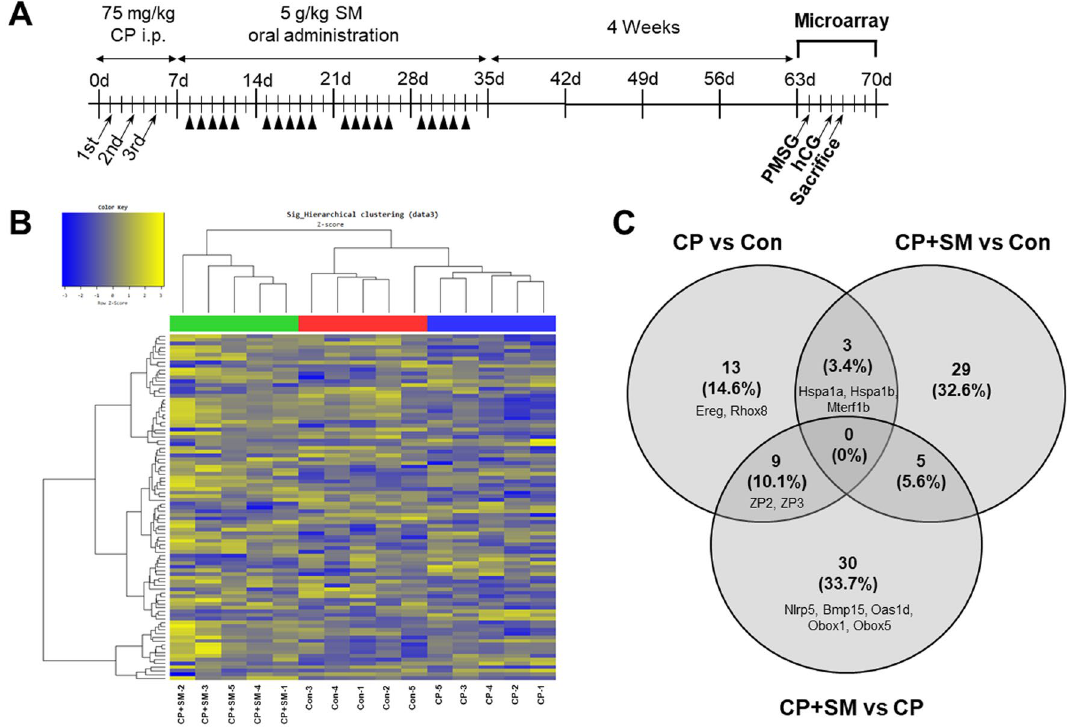
Figure 4. Hierarchical clustering and analysis of differentially expressed mRNAs. ( A ) Microarray was performed to compare the gene expression in ovulated ovaries of Con (n = 5), CP (n = 5), and CP + SM mice (n = 5). ( B ) Hierarchical clustering among the mRNA expression profiles. ( C ) Venn diagram showing 89 differentially expressed mRNAs in the three groups, with a fold-change > 1.5 and P < 0.05. Con saline-treated control mice; CP cyclophosphamide-treated mice; CP + SM CP-treated mice orally administered Samul-tang. Arrows and arrowheads indicate the day of CP injection and SM administration,